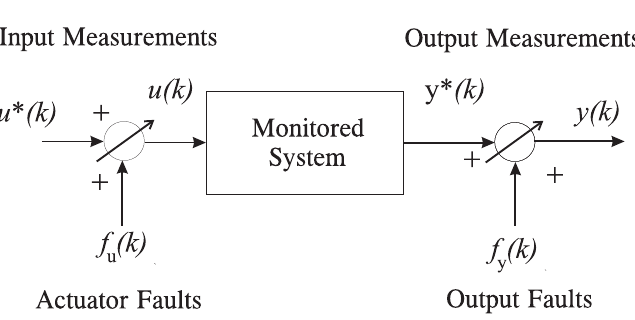
Figure 1. The monitored system.